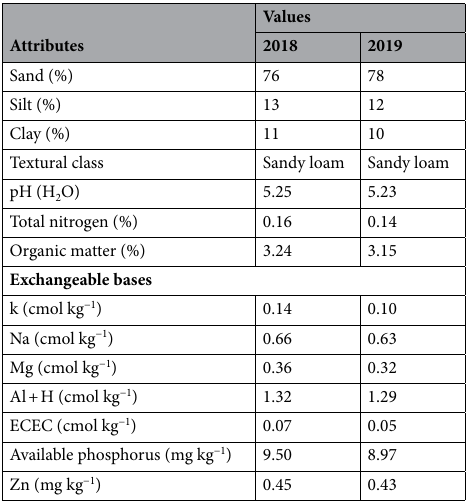
Table 1. Soil physical and chemical characteristics of the experimental sites at 0 -15 cm